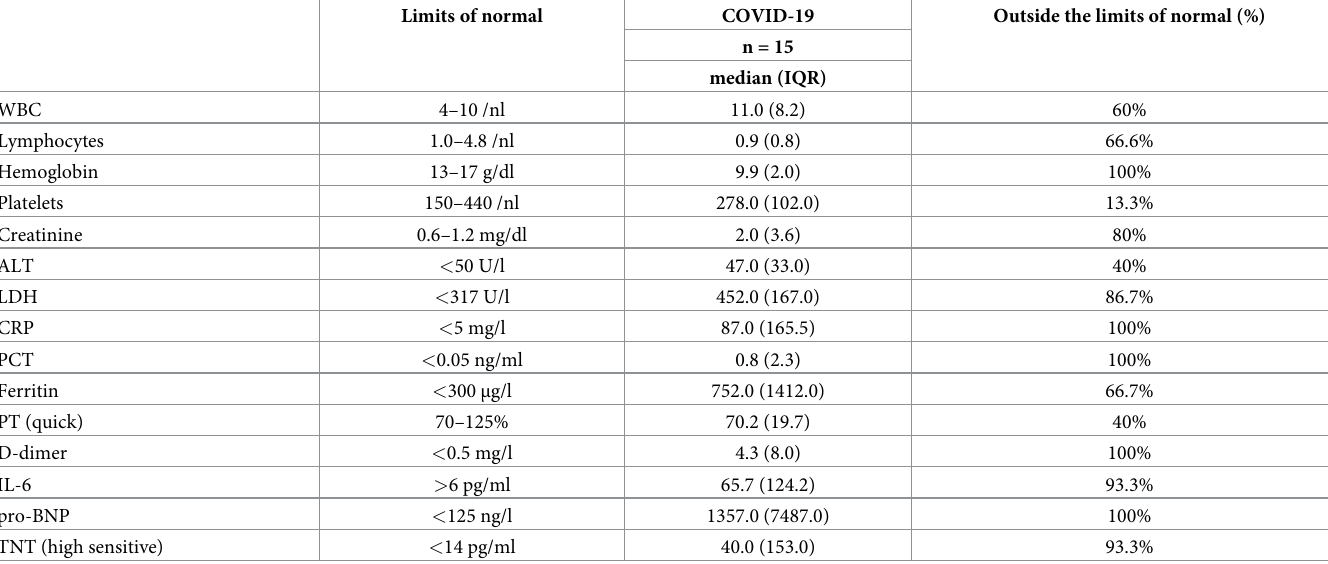
Table 2. Laboratory data in median (IQR) of study population.